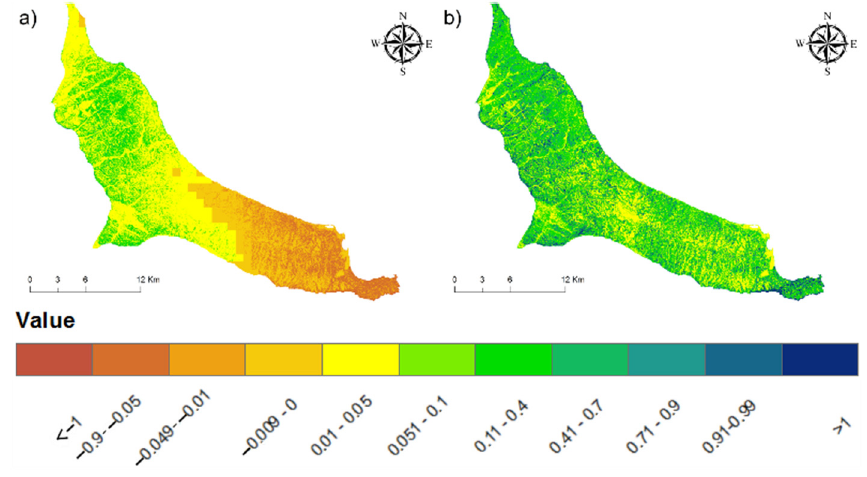
Figure 6. Spatial differences between the future soil loss ( a ) 2021–2050 and ( b ) 2071–2100 and the baseline period (1971–2000).